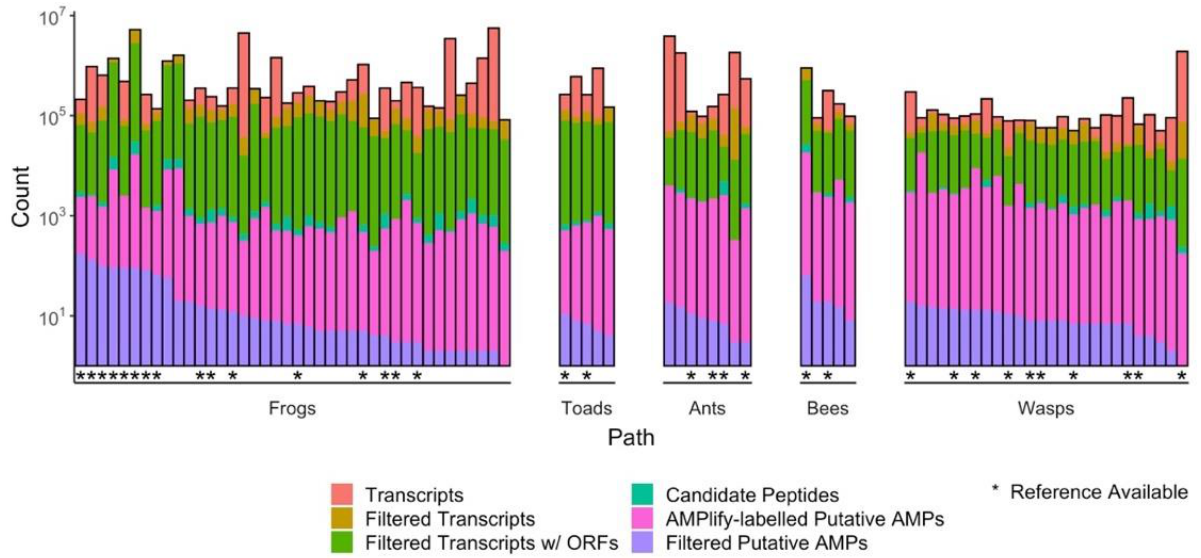
Figure 1. Statistics and attrition as the sequencing data are processed by the rAMPage AMP discovery pipeline. rAMPage processes RNA-seq datasets from raw reads to transcripts to putative AMPs. In this case, a putative AMP is defined as a sequence with an AMPlify score ≥ 10 for amphibians or ≥ 7 for insects, a length ≤ 30 AA, and a charge ≥ 2. Datasets with a reference transcriptome used during assembly are indicated with an asterisk. The total number of putative AMPs ( n = 1478, including 341 duplicates) are shown in purple, discovered from a total of ~53 million assembled